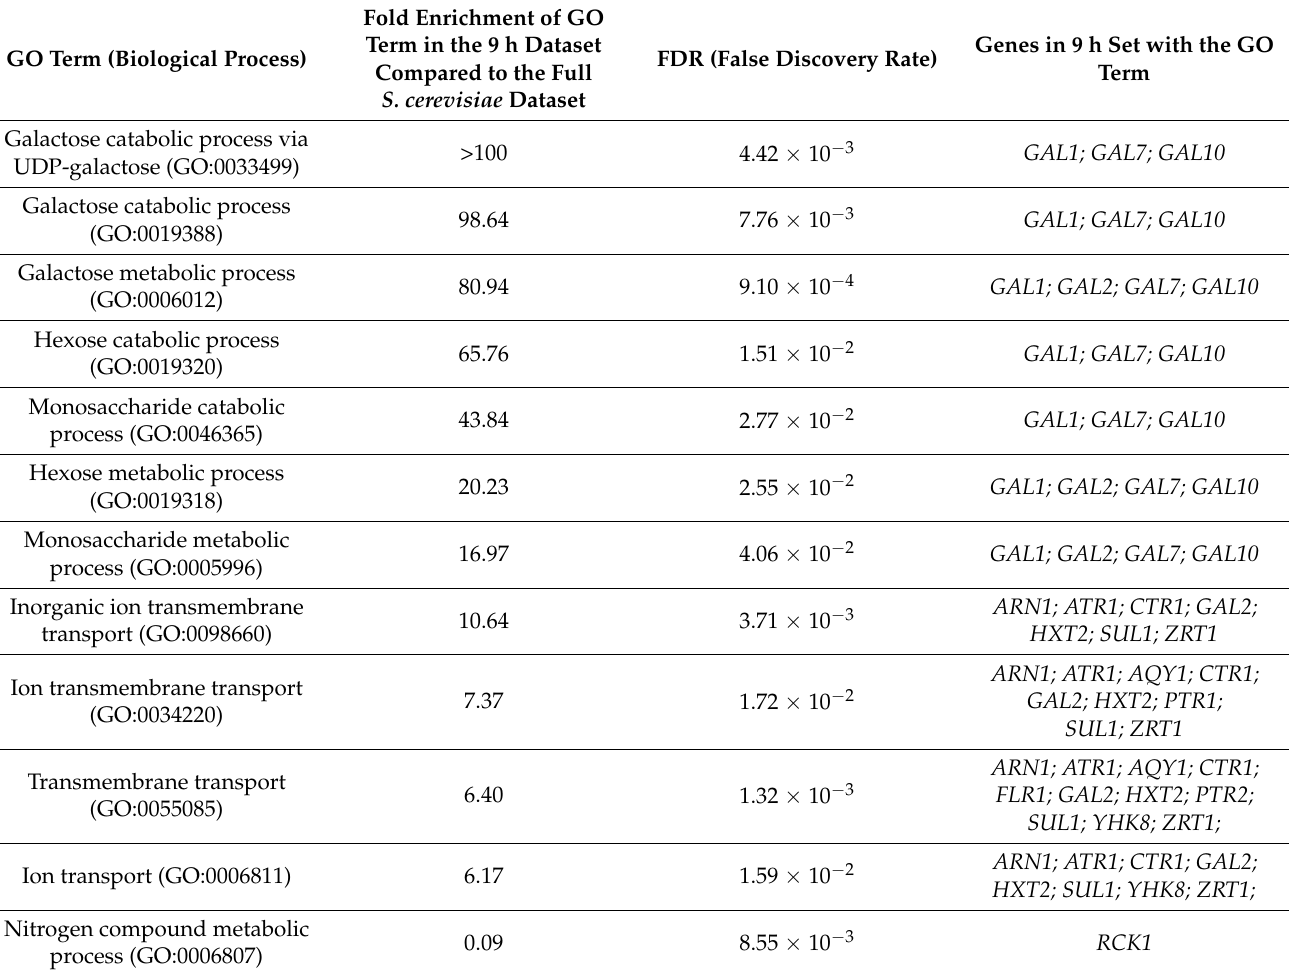
Table 3. Result of the Gene Ontology (GO) enrichment analysis for the 25 identified DE genes from the 9 h comparison (SH 9 h vs. SM 9 h). The table is sorted by fold enrichment. No significantly enriched GO terms were found when performing the same analysis on the 17 h DE genes (SH 17 h vs. SM 17 h). See Material and Methods for details on the